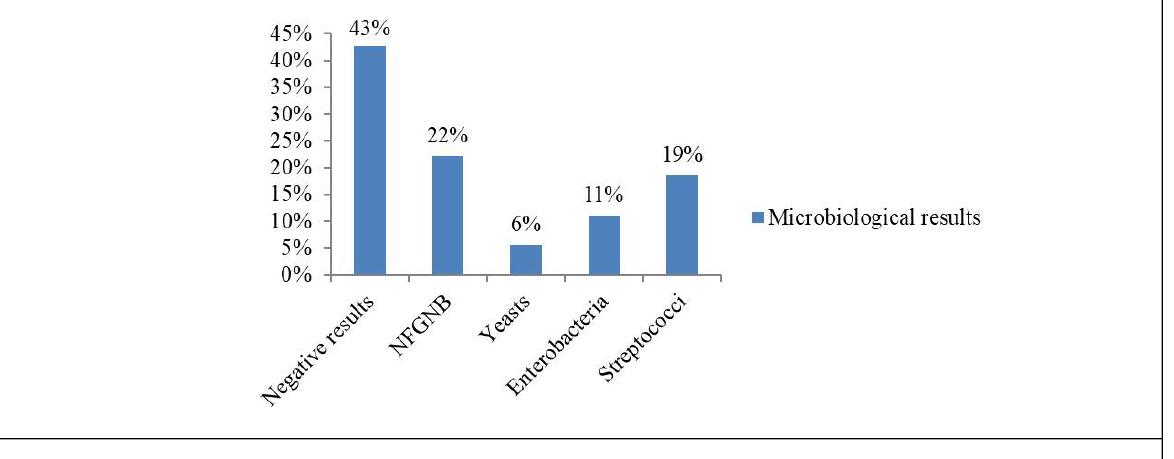
Figure 1: Microbiological results of the respiratory samples